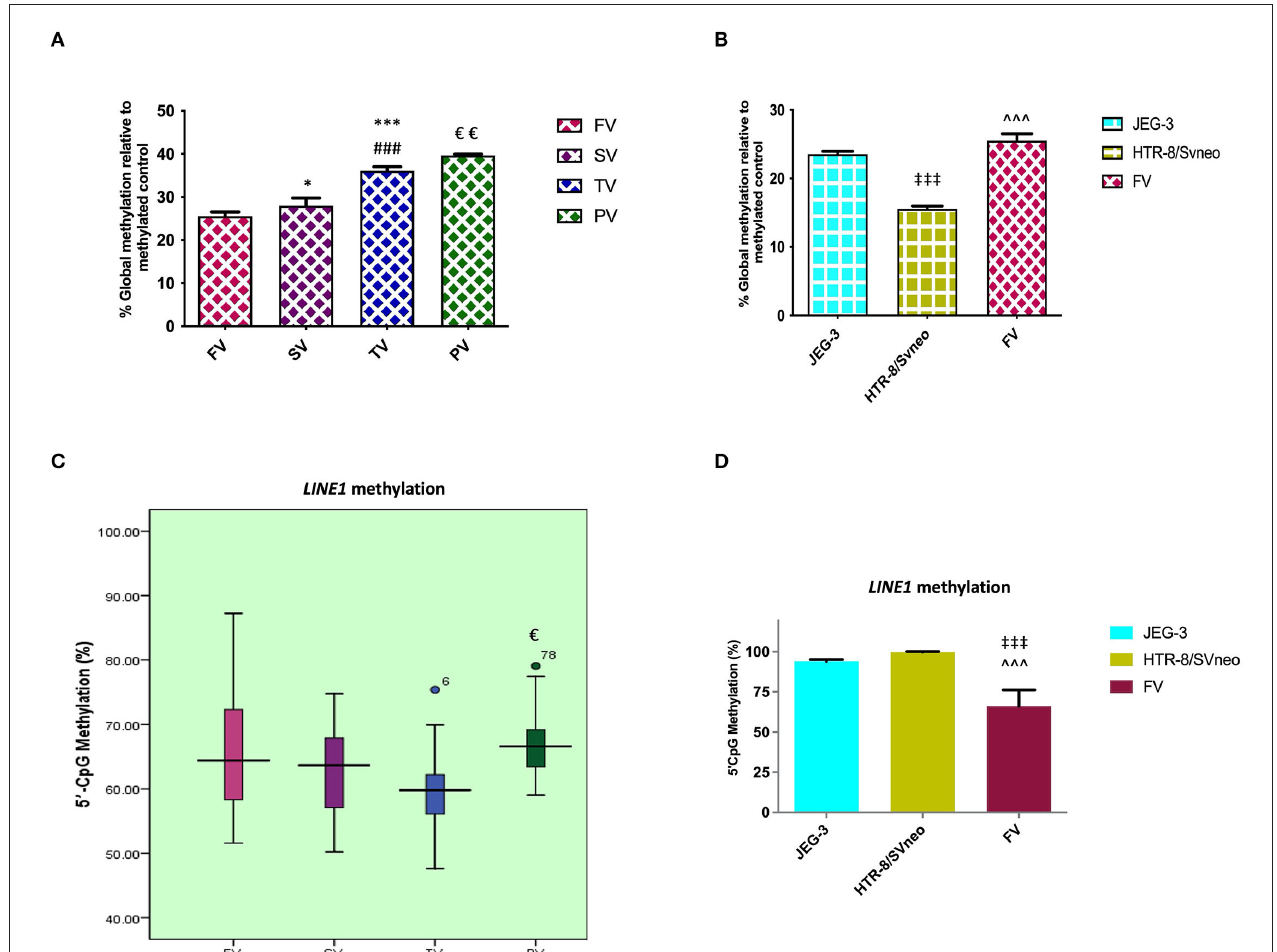
FIGURE 2 | Percentage of relative global methylation and promoter region methylation for LINE1 , (A, B) relative percentage global methylation (A) among different villi samples (B) among different placental cells viz JEG-3, HTR-8/Svneo, and first trimester villi. (C, D) Graphical representation of 5’CpG methylation (%), (C) among different villi samples (D) among different placental cell lines viz JEG-3, HTR-8/Svneo, and first trimester villi. The data are expressed as mean ± SEM. FV, SV, TV, and PV -first trimester, second trimester, third trimester, and preeclampsia placental villi samples respectively. [* p < 0.05, *** p < 0.001 with respect to FV, ### p < 0.001 with respect to SV and € p < 0.05, €€ p < 0.01 with respect to TV] [ ‡‡‡ p < 0.001 with respect to JEG-3, ∧∧∧ p < 0.001 with respect to HTR-8/SVneo].